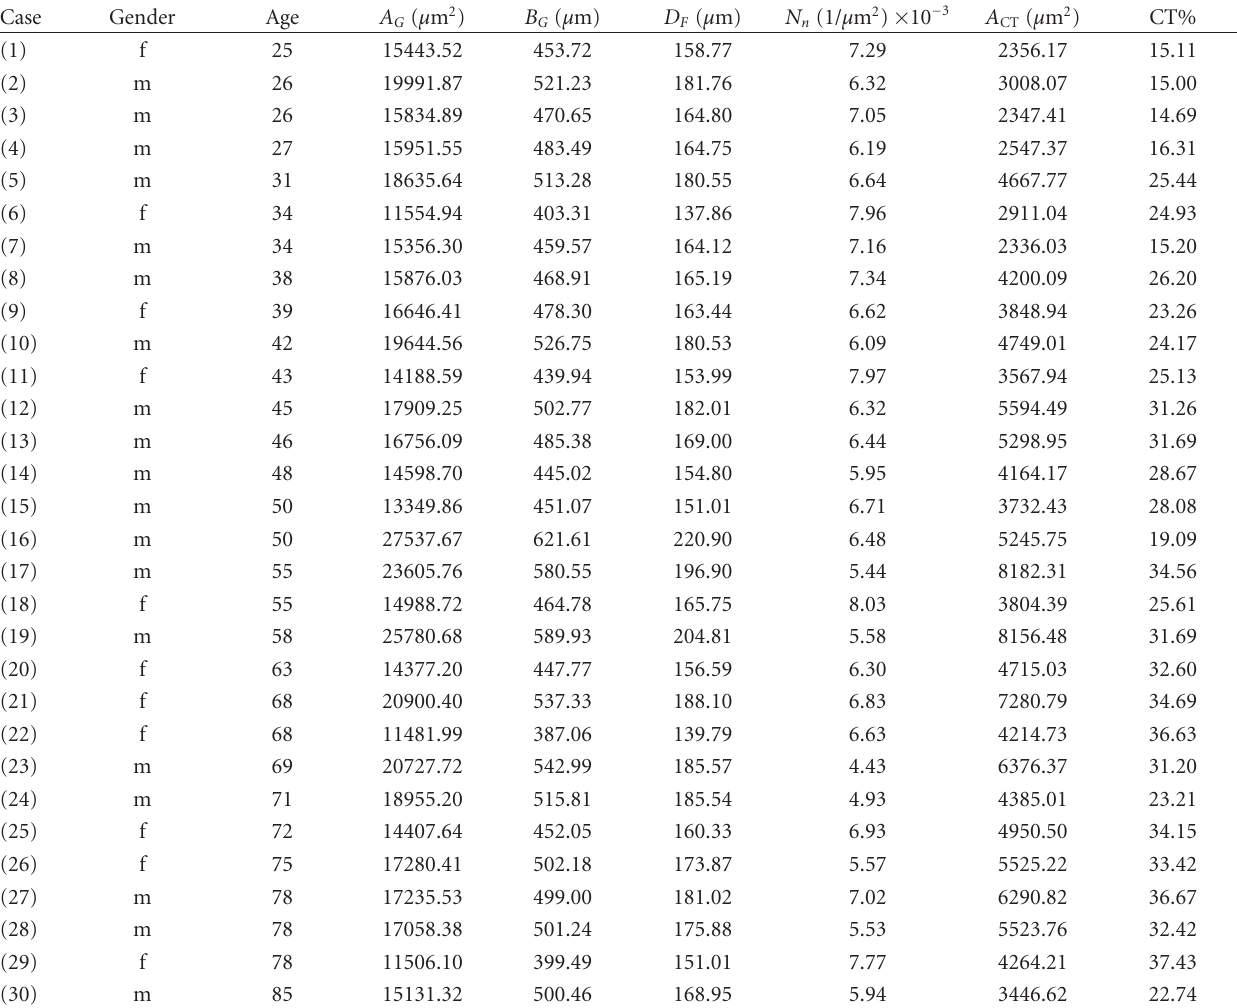
Figure 1: Average connective tissue area of nonsclerosed glomeruli during the aging process (a); average percentage of connective tissue in nonsclerosed glomeruli during the aging process (b). Table 1: Morphometric parameters average values of nonsclerosed glomeruli in all 30 evaluated